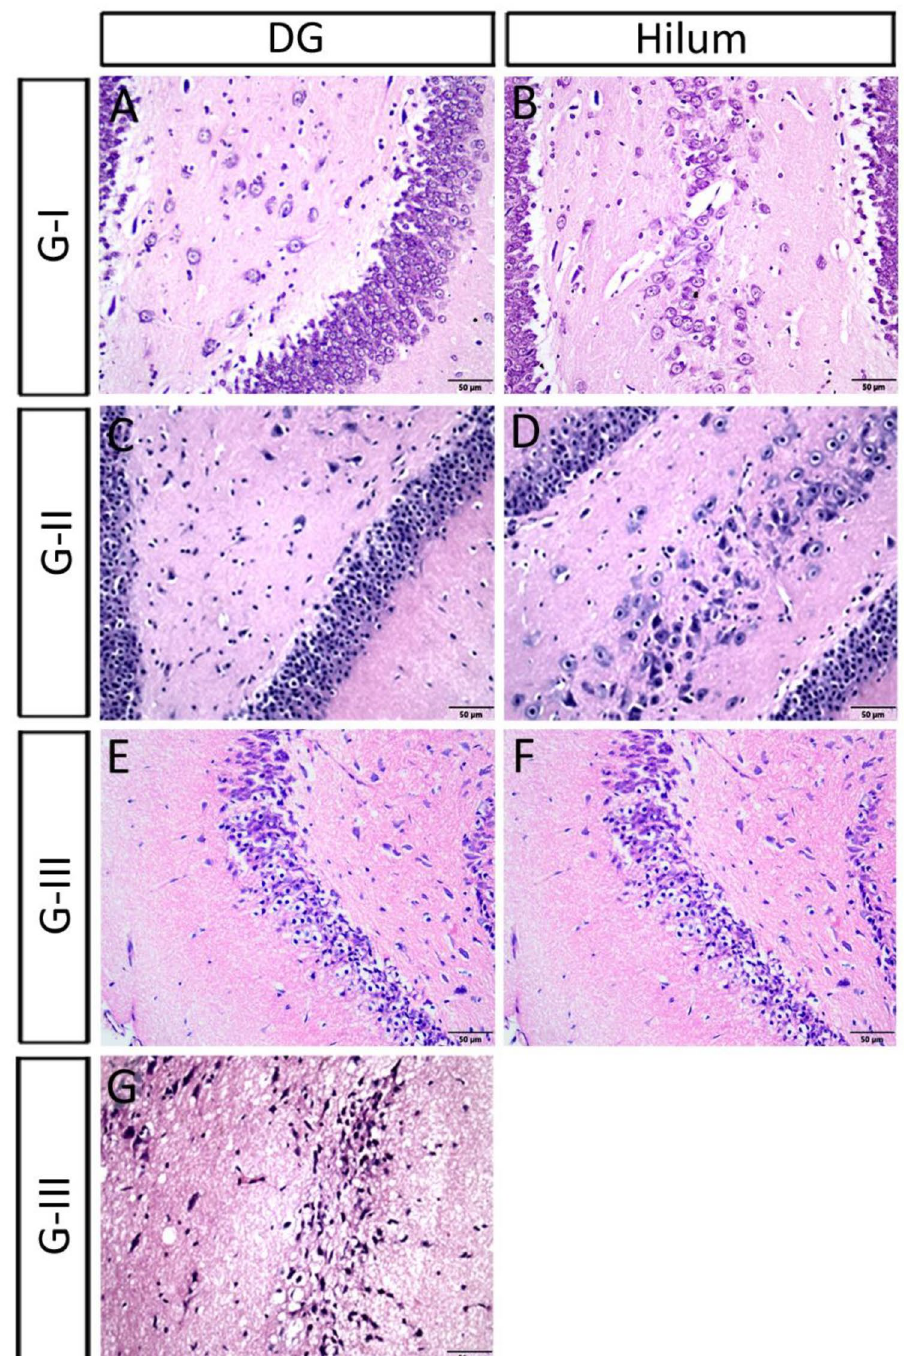
Figure 4. Showing the microscopic features of scopolamine administrated groups: ( A , B ) the granular layer and cells in the hilum of the control. ( C , D ) In group II, most of the granular layers and hilum cells became BC cells. ( E , F ) In group III, both densely stained elongated cells and a lot of BC were shown in the granular layer and the cells of the hilum. ( G ) A rat of the ES group showed a severely deformed hippocampus, where the DG had no hilum and the granular cells were severely reduced, with only a few remaining condensed, and dysmorphic cells and separated by large